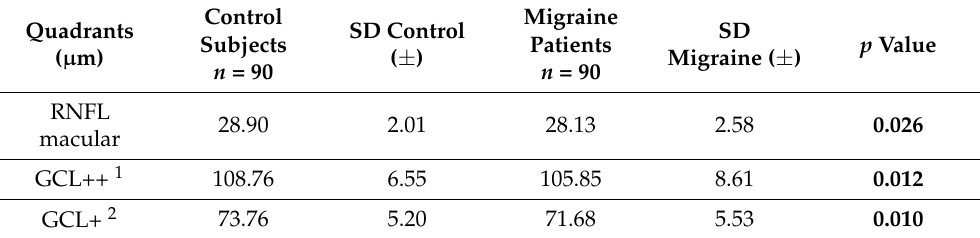
Table 6. RNFL macular, GCL++, and GCL+ thickness ( µ m). Quadrants ( µ m)